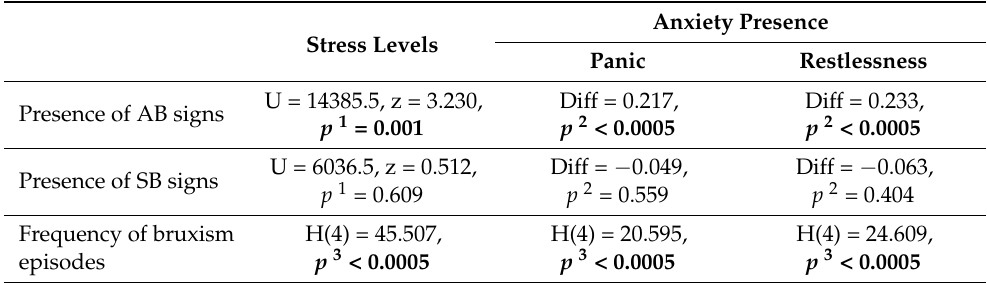
Table 2. Statistical results following group distribution analysis of presence of AB signs, SB signs, frequency of bruxism episodes, and declared stress and anxiety levels. Anxiety Presence Stress Levels Panic